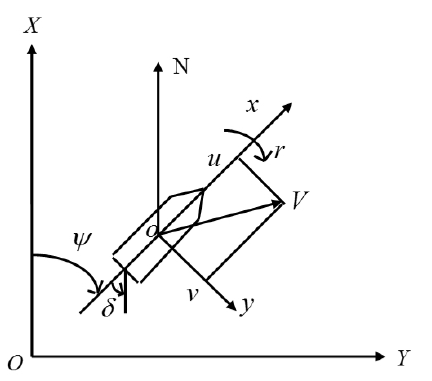
Figure 3. The description of vector propulsion USV motion